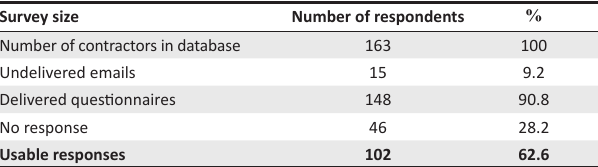
TABLE 1: Survey size and response rate.